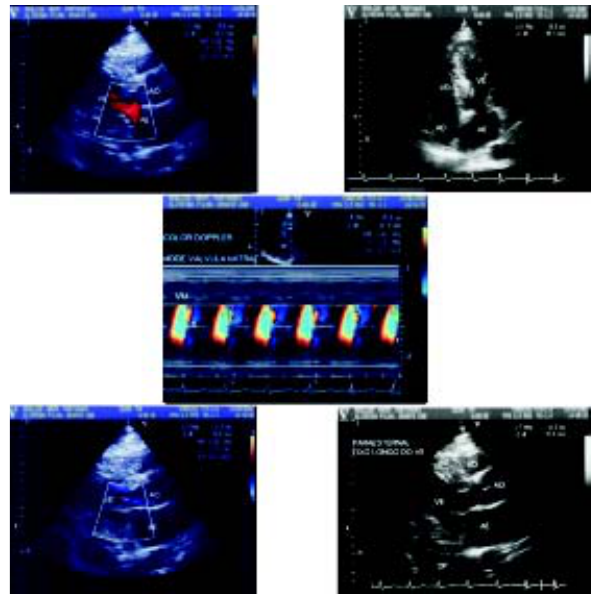
Fig. 4 - Ecotransesofágico